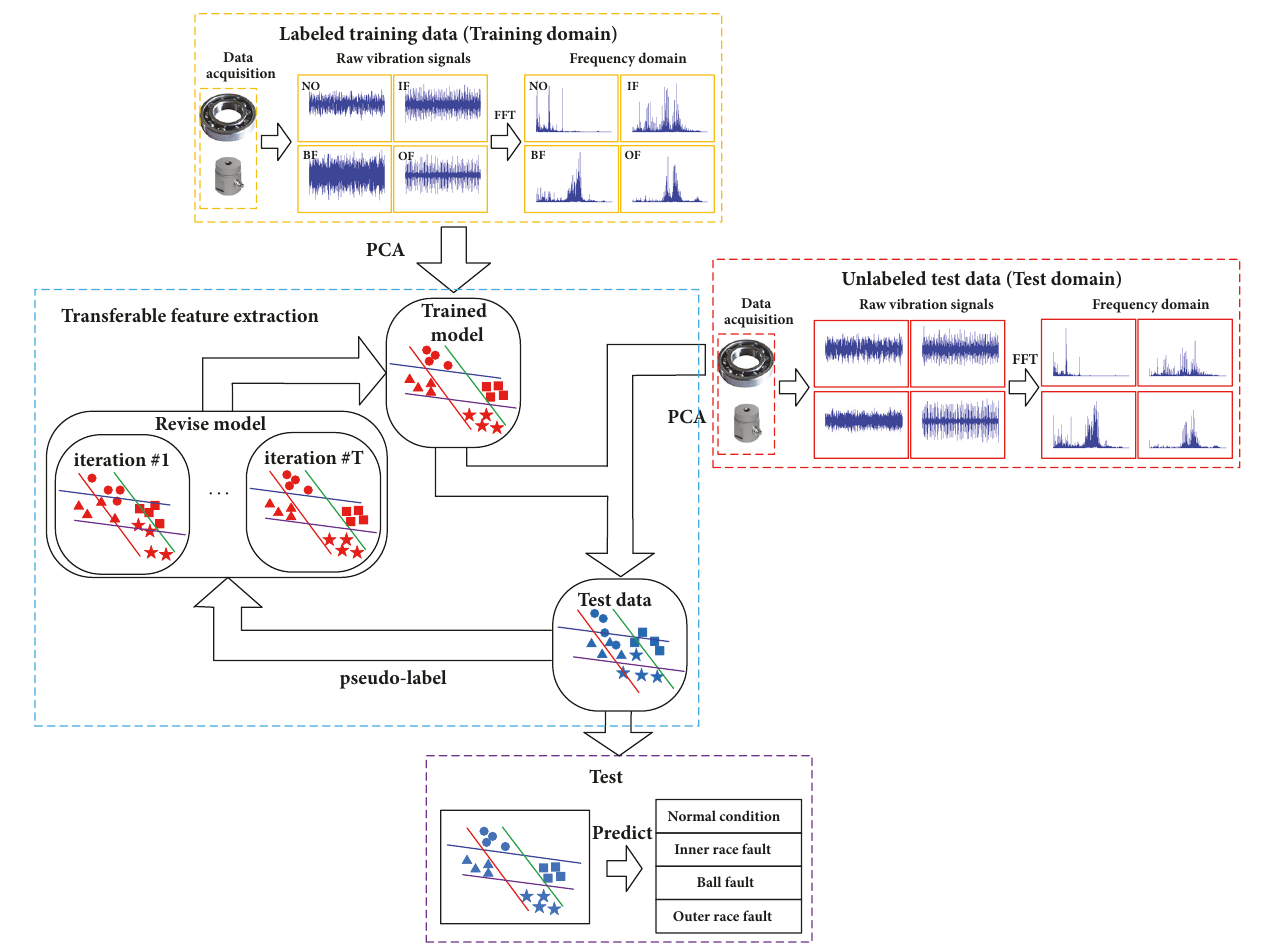
Figure 1: The framework of DATF for variable working condition fault